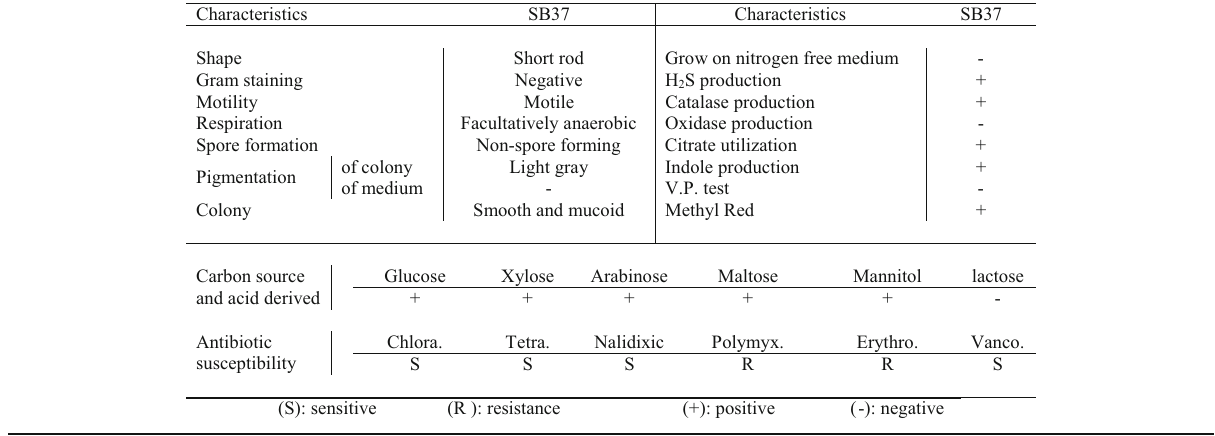
Table 3 Morphological, cultural, biochemical characteristics and antibiotics susceptibility of the highest BS-producing bacterial isolate